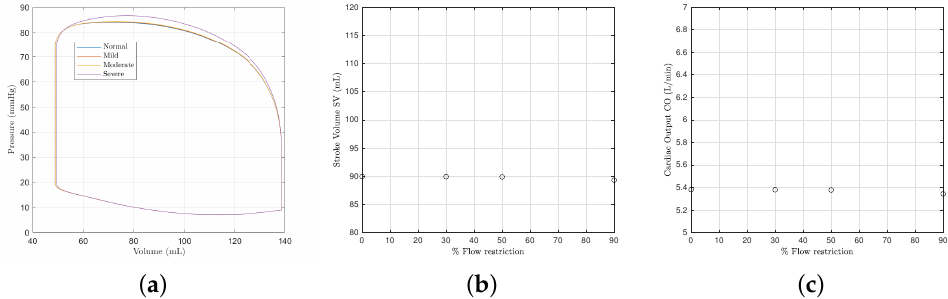
Figure 5. Left ventricle pressure–volume loop, the stroke volume and the cardiac output with different severities of aortic valve stenosis. ( a ) Pressure–volume loops. ( b ) The stroke volume. ( c ) The cardiac output.